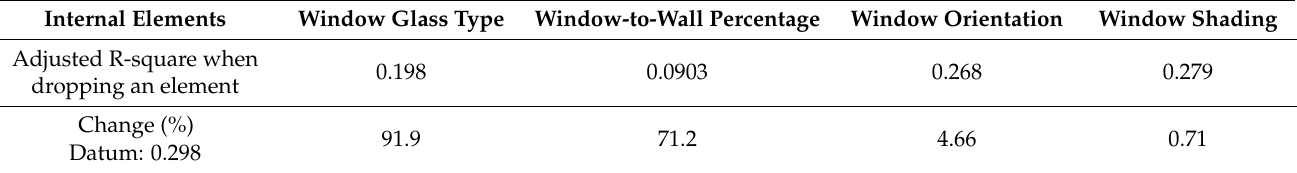
Table 8. Change in adjusted R-square when dropping an